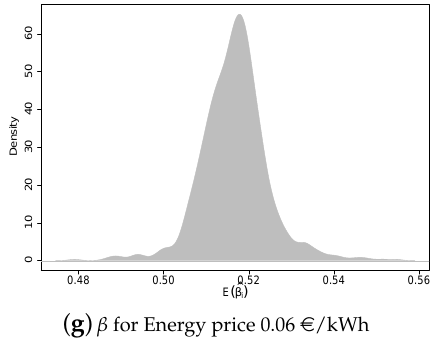
( g ) β for Energy price 0.06 e /kWh Figure 4. Kernel density functions of individual parameters distribution for RPL model.